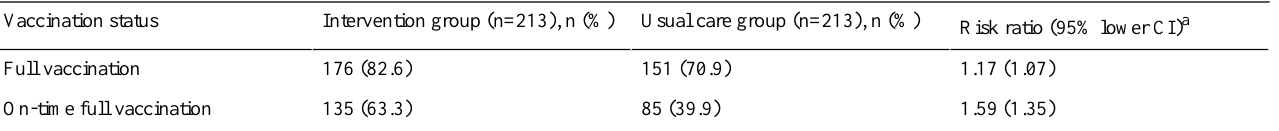
Table 5. Log-binomial regression analysis of the effect of mobile phone text message reminders on the primary outcomes in Gondar city, northwest Ethiopia in 2020